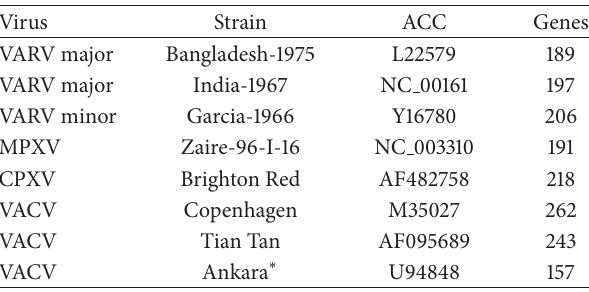
Table 1: Orthopoxviruses used in this